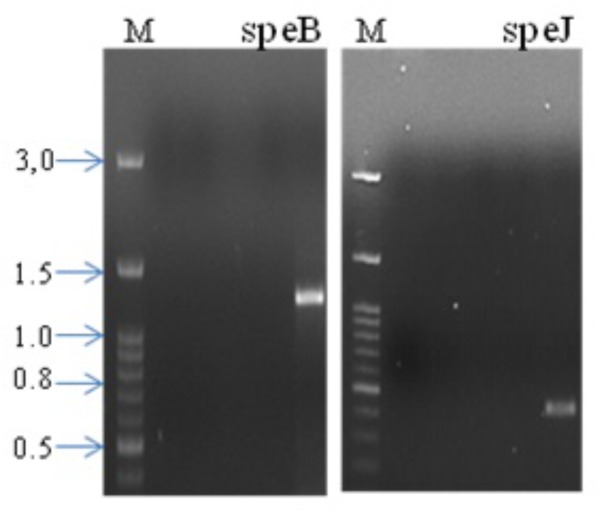
Virulence genes detection in Streptococcus pyogenes NBMKU12 isolate. M, Marker DNA (100 bp DNA Ladder H3 RTU, GeneDireX), speB amplification (1.2 kb), speJ (535 bp).